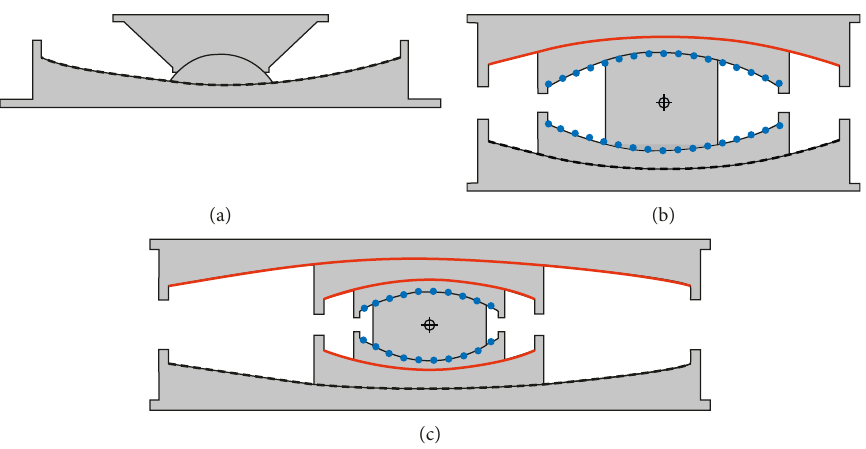
Figure 7: PBD levels in terms of isolator displacements for (a) SFPB, (b) TFPB, and (c) QFPB isolation schemes.